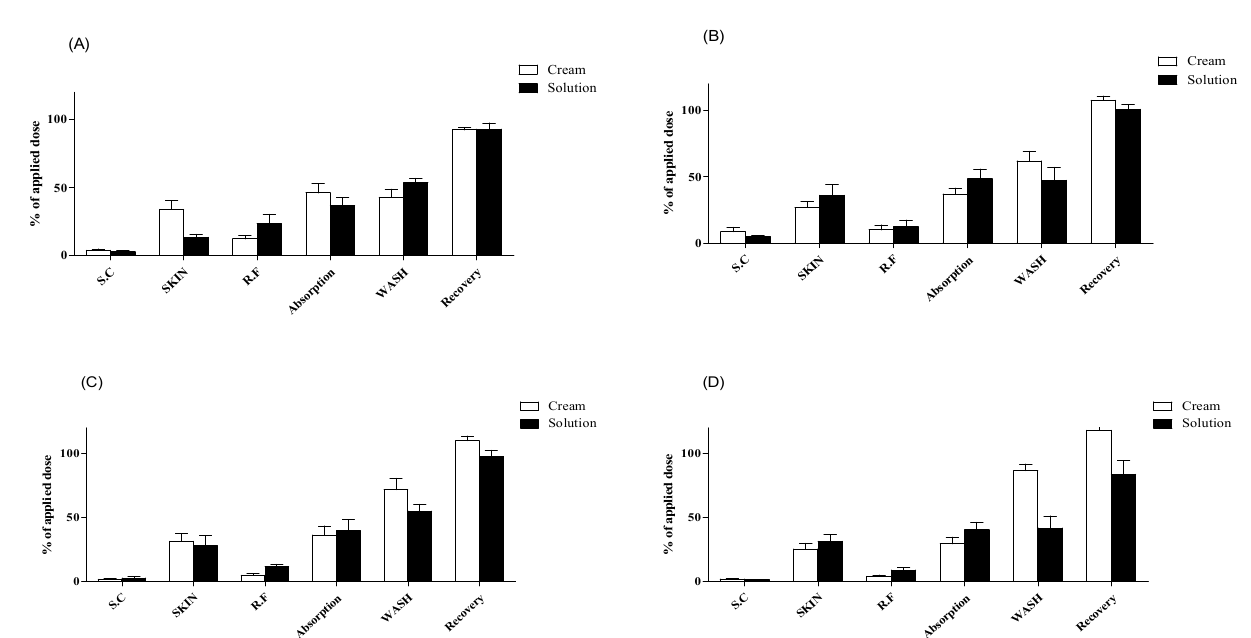
Figure 1. Dermal absorption of caffeine in rat skins ( n = 4, mean ± SD). Dermal absorption test results with doses of ( A ) 5 mg/cm 2 or 5 µ L/cm 2 , ( B ) 10 mg/cm 2 or 10 µ L/cm 2 , ( C ) 25 mg/cm 2 or 25 µ L/cm 2 , and ( D ) 50 mg/cm 2 or 50 µ L/cm 2 . SC, stratum corneum; SKIN, dermis and epidermis; RF, receptor fluid; WASH, remaining formulation rinsed using alcohol swabs.